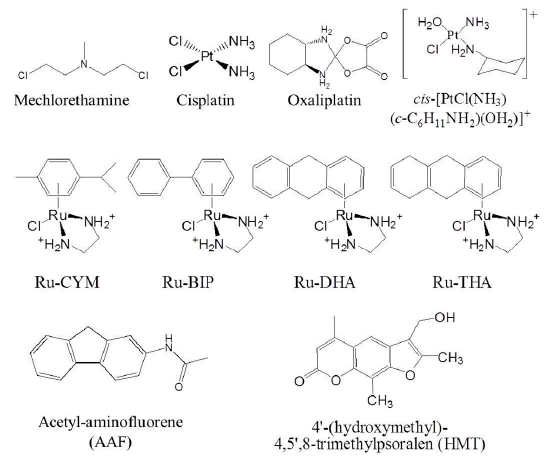
Figure 1. Structures of the DNA major groove alkylating agents presented in this review.